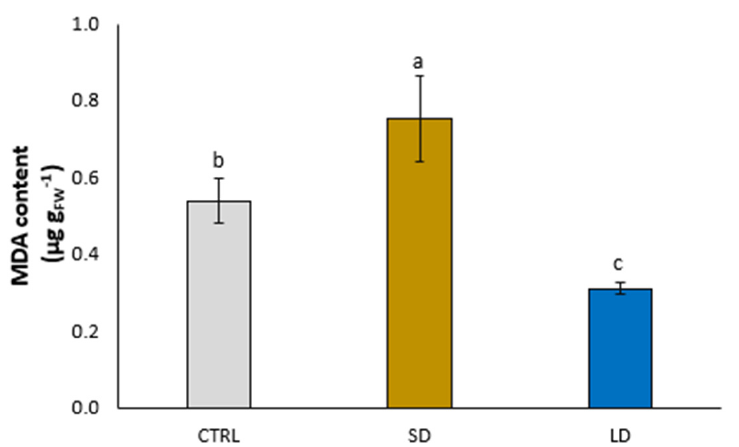
Figure 4. Malondialdehyde (MDA) content in leaves of lettuce plants grown for 5 weeks without (CTRL) and with the application of digestate, either solid (SD) or liquid (LD). Parameters are expressed as mean ± standard error. Different letters indicate statistically significant differences ( p < 0.05).